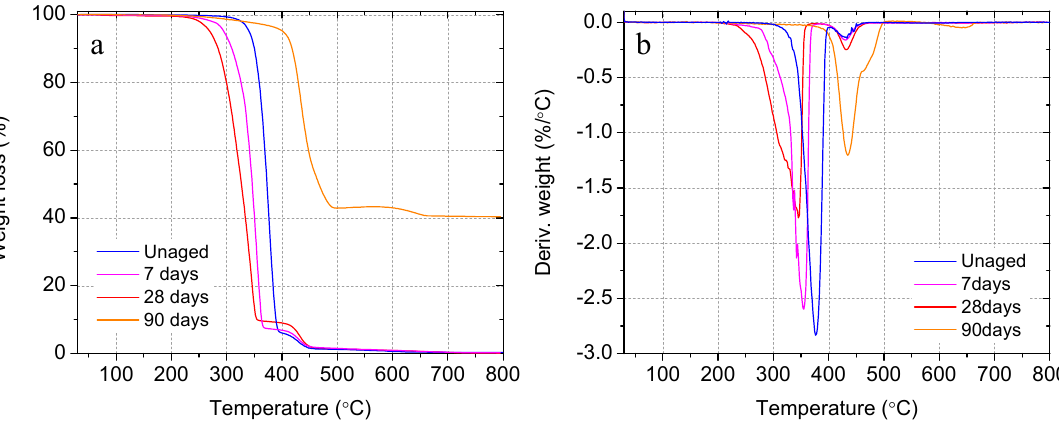
Figure 11. Comparison of degradation of PLA capsules in cement paste under 50 °C lime water: ( a ) thermogravimetric weight loss, and ( b ) derivative of weight loss. Table 4. Degradation of PLA capsules in the matrices of concrete, mortar and cement paste under different curing conditions. Matrix